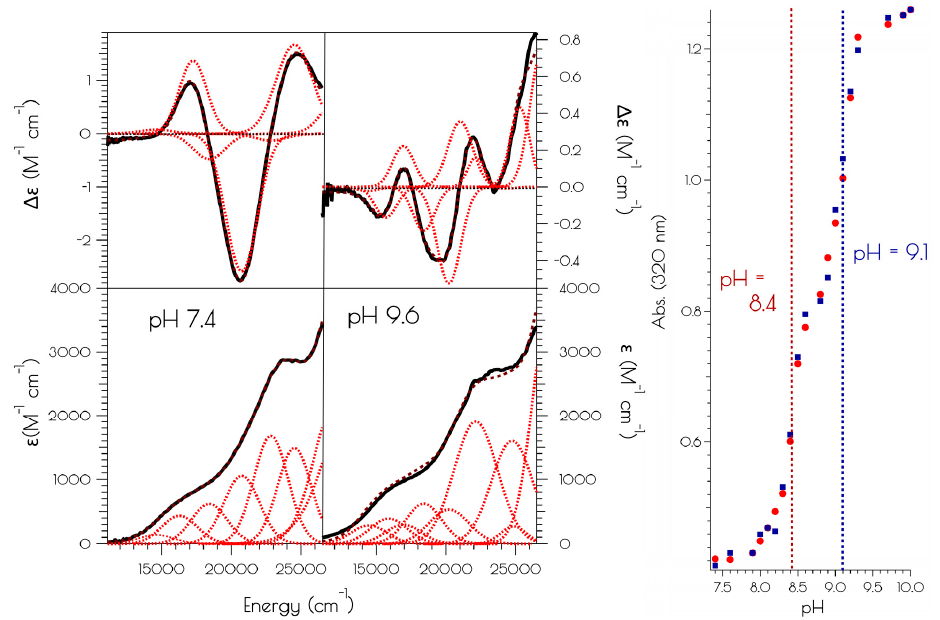
Figure 2. Left: electronic absorption spectra (bottom) and CD spectra (top) of {Ni 2II (SOD mds )} at pH 7.4 and 9.6. The solid black spectra represent the experimental data, the red dashed curves represent the individual transitions deconvolved from the spectra and the dashed black spectra represent the convolution of the individual transitions. Right: pH profile showing the change in absorbance at 320 nm vs. change in pH upon going from pH 7.4 to 9.6 (red circles) and pH 9.6 to 7.4 (blue